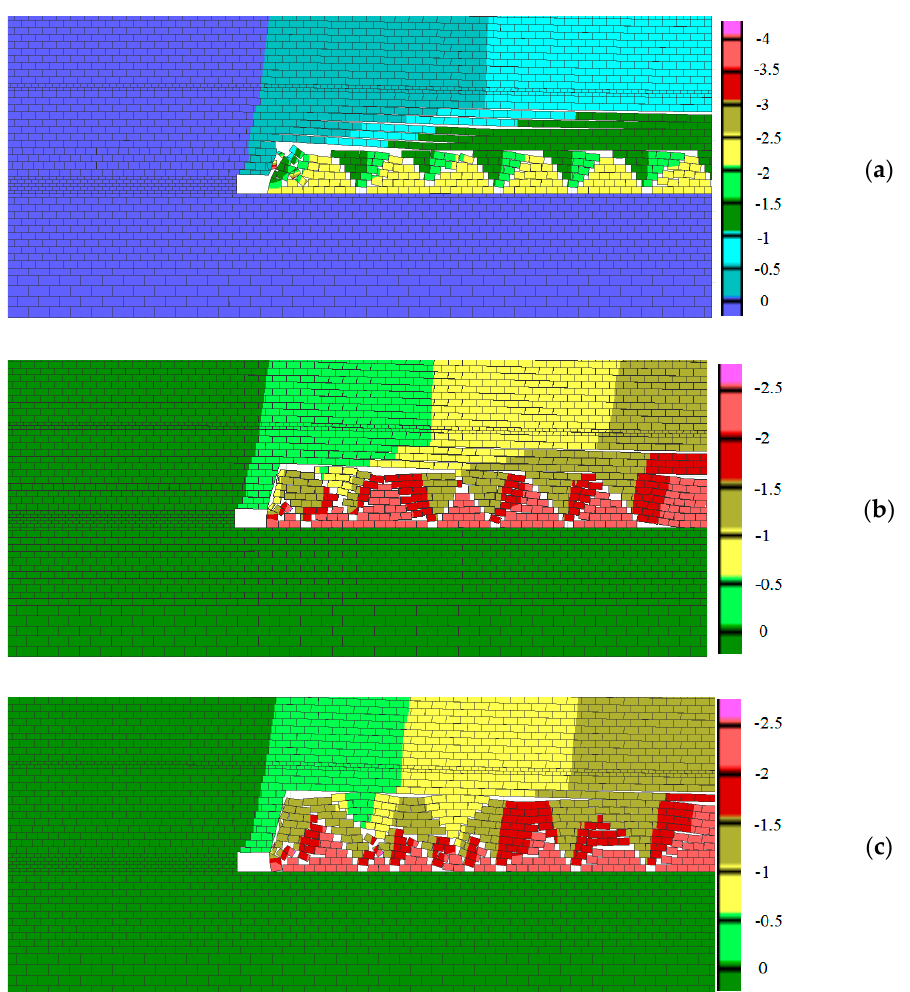
Figure 6. Collapse morphology and vertical displacement model (unit: m). ( a ) Roof cutting height 5.5 m, ( b ) Roof cutting height 7 m, ( c ) Roof cutting height 8.5 m. 5.5 m, ( b ) Roof cutting height 7 m, ( c ) Roof cutting height 8.5